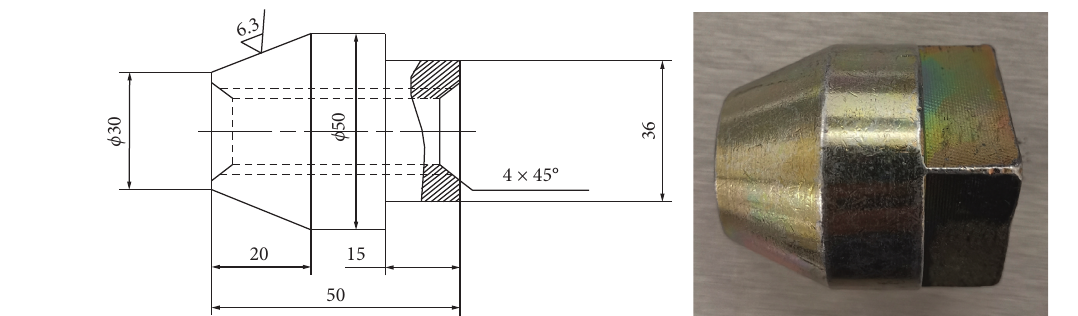
Figure 2: Diagram of special-shaped nut.